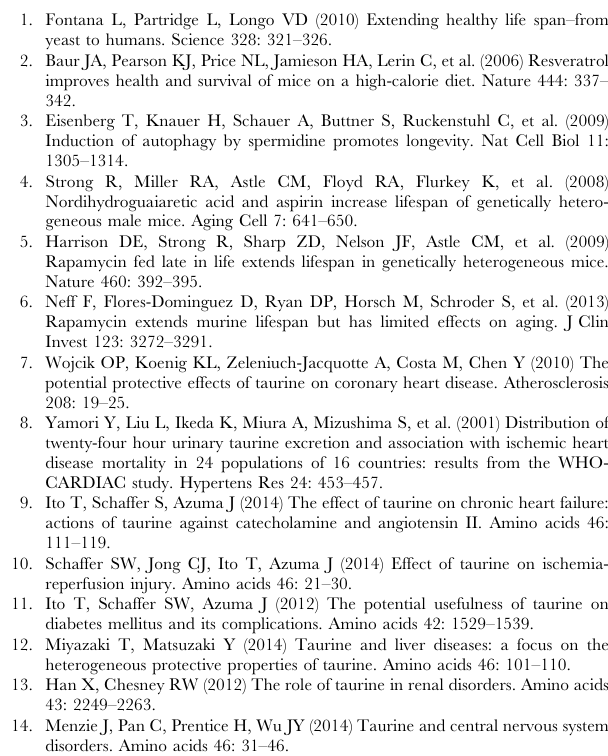
shows no red-ragged fibers in aged TauTKO muscle. Similar results were obtained from 3 independent experiments. Table S1 Top 50 genes increased or decreased in old TauTKO muscles than old WT muscles. Table S2 Top 50 genes increased or decreased in young TauTKO muscles than young WT muscles. Table S3 Biological function identified by IPA of increased or decreased genes of old TauTKO muscle. Table S4 Biological function identified by IPA in overlap genes which are significantly changed in both young and old TauTKO